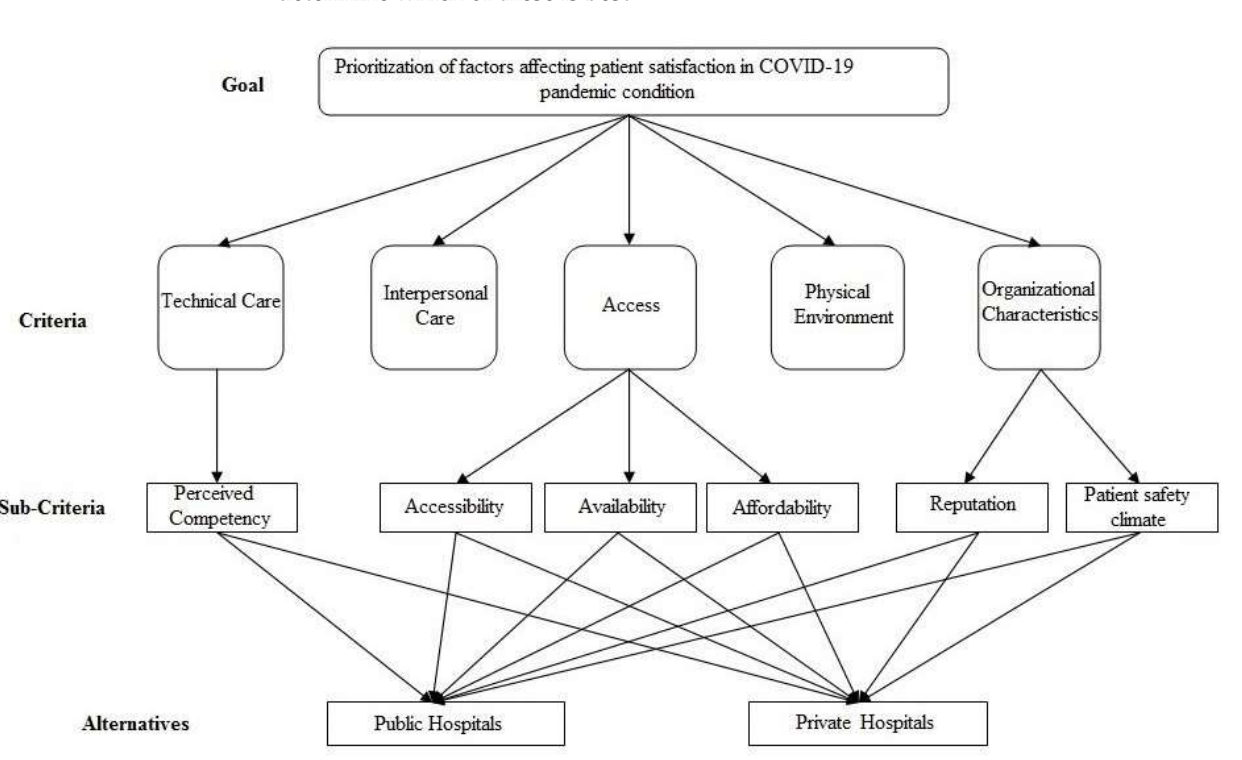
Figure 1. Top-level criteria and indicators of each